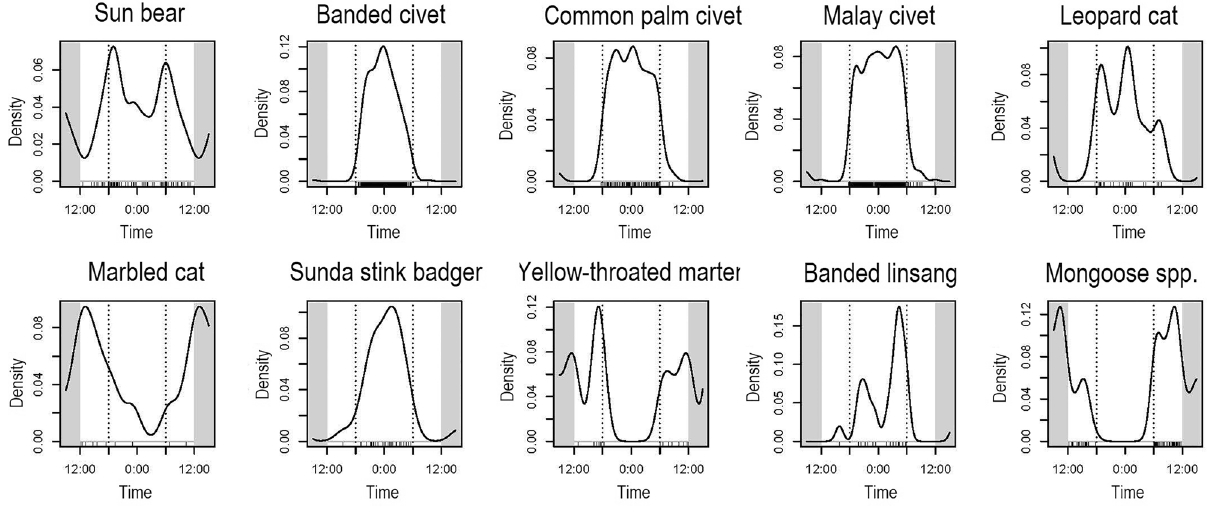
Figure 2. Temporal activity patterns of the ten carnivore species estimated by kernel density estimates. Dotted vertical lines indicate approximate times of sunset and sunrise, and short vertical lines under the kernel density curves indicate photo-captured times of each